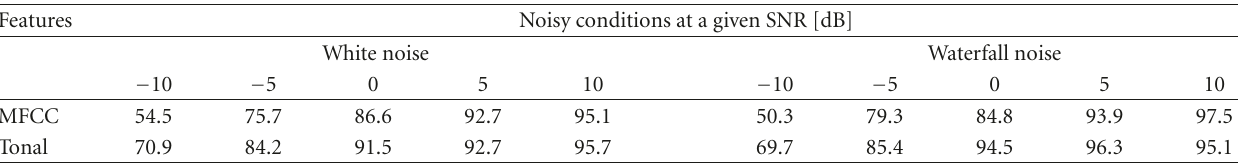
Table 3: Bird syllable recognition accuracy on noisy data obtained by the multi-condition model employing the MFCC and tonal-based features.